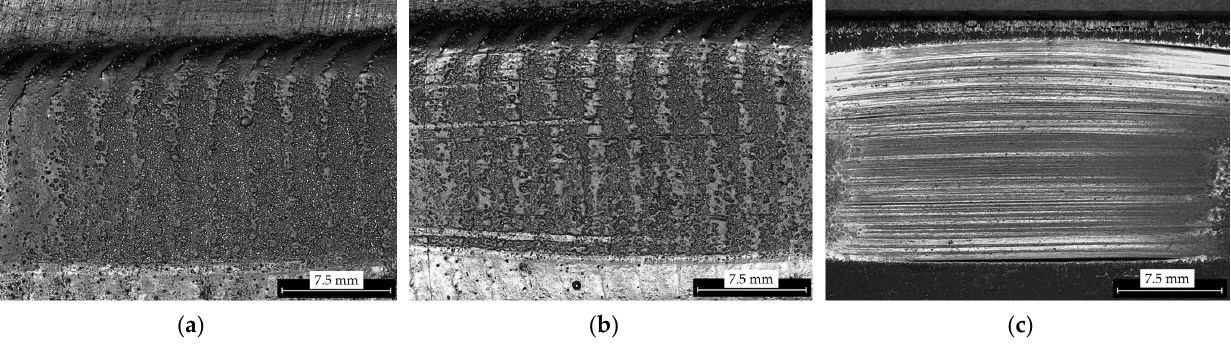
Figure 12. Surface of coating layers after abrasive wear resistance tests ( a ) surface of layer of sample 1-PG prepared using PG powder ( b ) surface of layer of sample 1-PE prepared using PE powder ( c ) surface of reference material AR400.